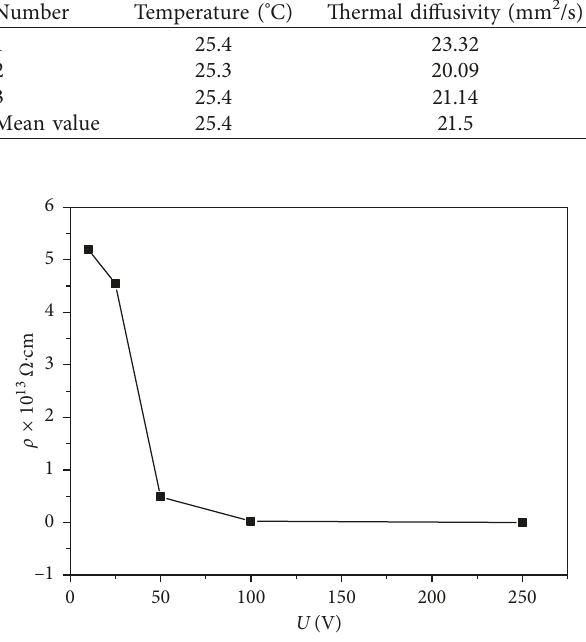
Figure 4: Specific electrical resistance of the specimen under different